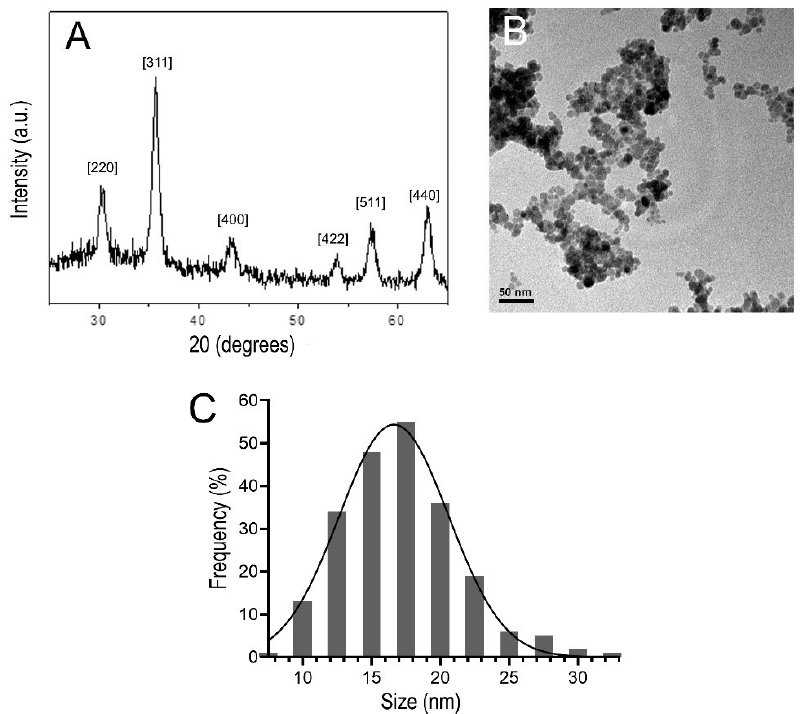
Figure 2. ( A ) X-ray powder diffraction pattern of DMSA-MNP, in the angular range from 20° to 70°. ( B ) Typical transmission electron micrograph of DMSA-MNP. ( C ) Nanoparticle size distribution histogram in DMSA-MNP.